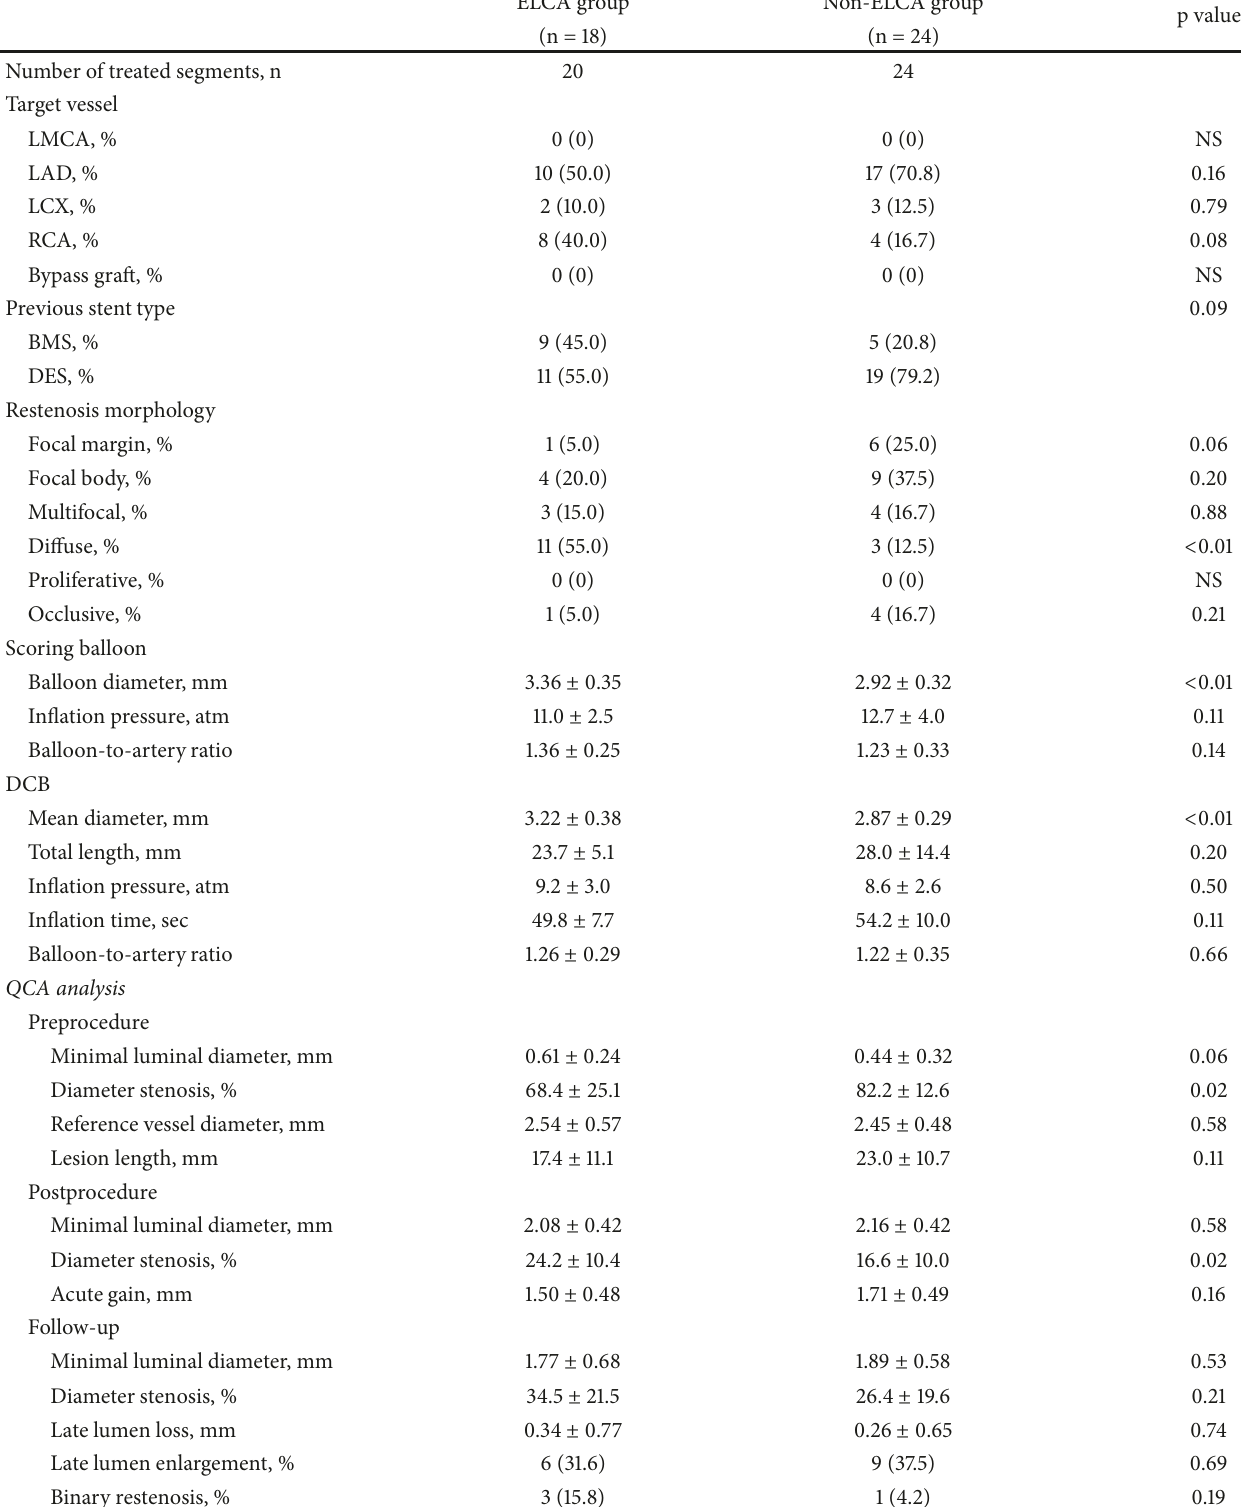
Table 2: Angiographic and procedural